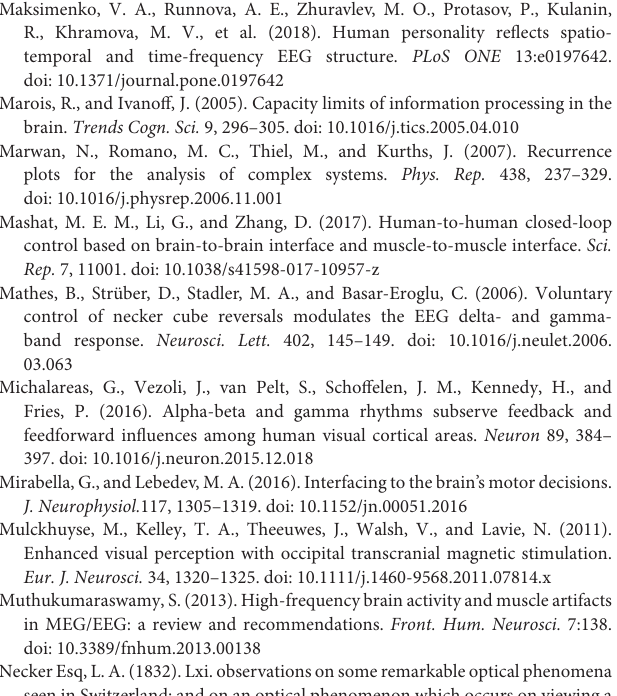
figure of a crystal or geometrical solid. Lond. Edinb. Dublin Philos. Mag. J. Sci. 1, 329–337. doi: